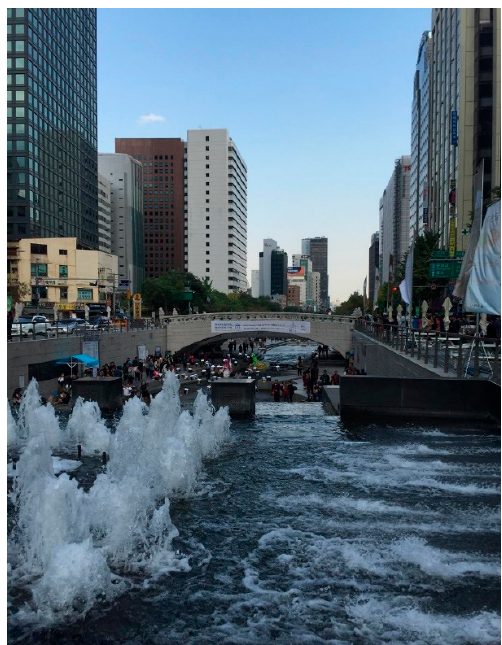
Figure 4. View from Cheonggye plaza, into the start of first section. Humanities 2020 , 9 , x